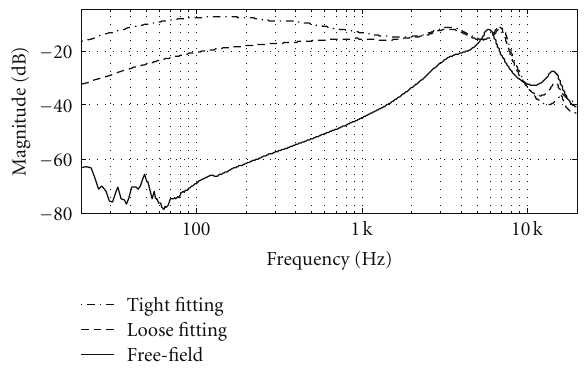
Figure 2: Frequency response of a headphone measured in free- field and in an ear canal simulator with tight and loose fitting (with 1/12 octave smoothing) [9].